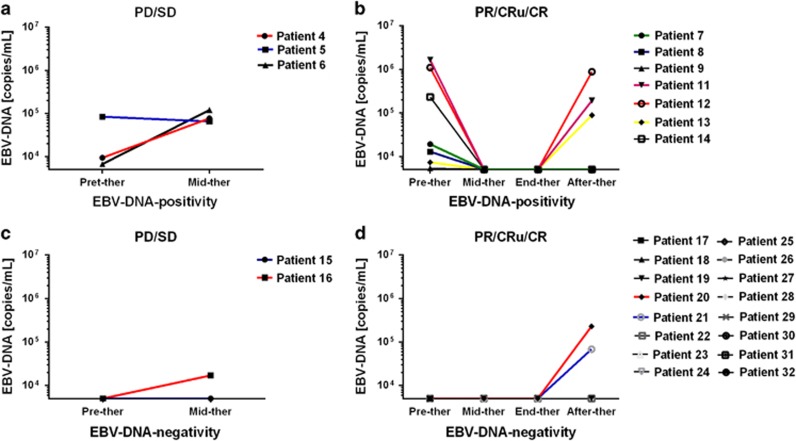
Serial analysis of quantitative Epstein–Barr virus (EBV)-DNA in 28 patients categorized into two groups: stable disease (SD)/progression disease (PD) (a, c), and complete response (CR)/CR undefined (CRu)/partical response (PR) (b, d).